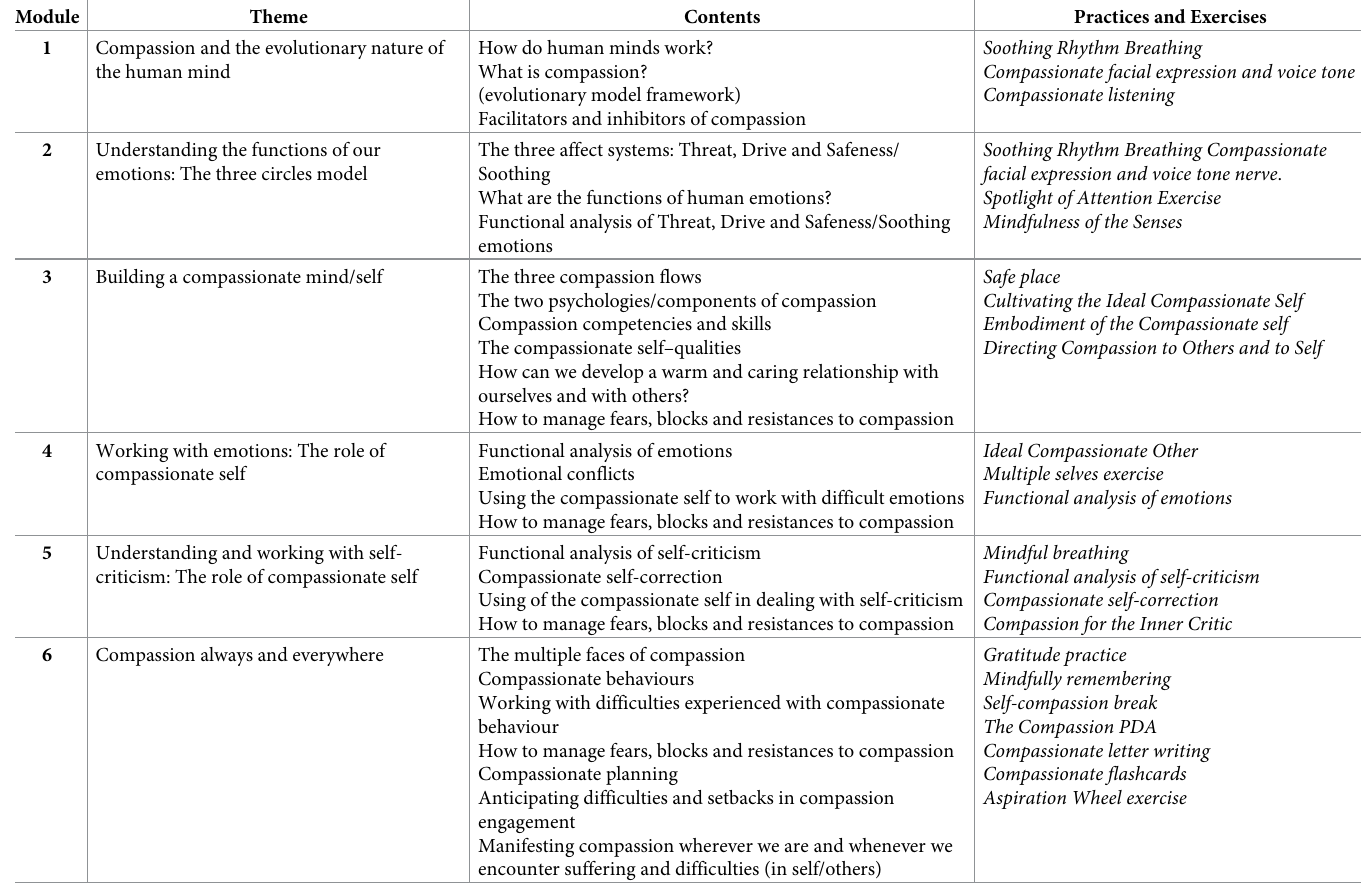
Table 2. CMT-T modules, contents, practices and